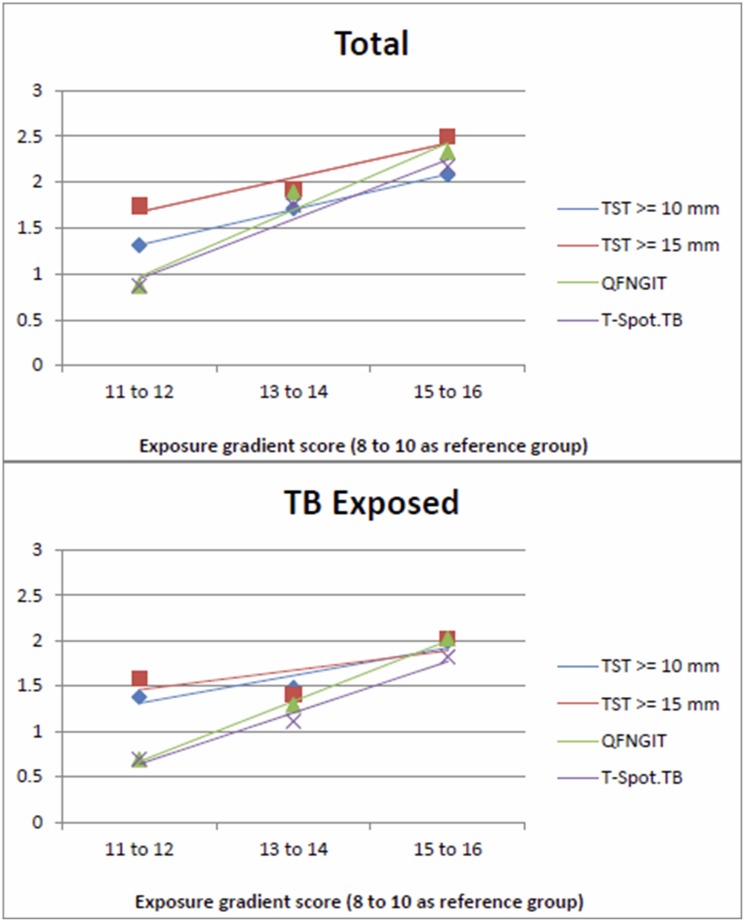
The regression lines of the natural logs of the odds ratios (y-axis) for TST≥10 mm, TST≥15 mm, QFNGIT, and T-Spot.TB for each TB exposure gradient category (x-axis), with TB contact score of 8–10 as the reference group.